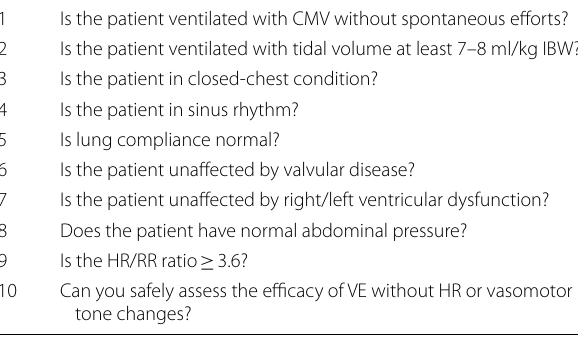
Table 2 “Validity criteria checklist” before performing volume expansion based on pulse pressure variation/similar methods‑ provided information. Adapted from